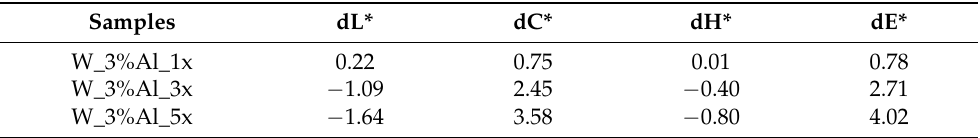
Table 13. Change in color coordinates of wool sample treated with 3% Al mordants after 1st, 3rd and 5th washing cycle (compared with W_3%Al_0x). Samples